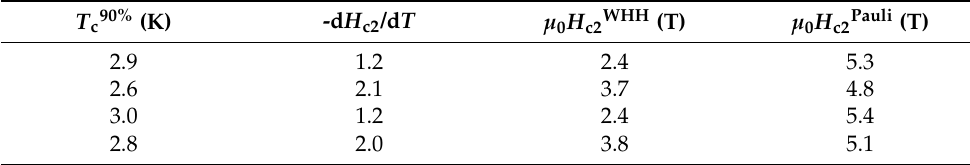
Figure 5. ( a ) Temperature dependence of the upper critical magnetic field. ( b ) illustrates ( a ) using normalized axes. Vertical and horizontal axes were normalized using Pauli’s limit H p and T c , respectively. Table 1. T c and H c2 values estimated by the WHH model and the Pauli limit.